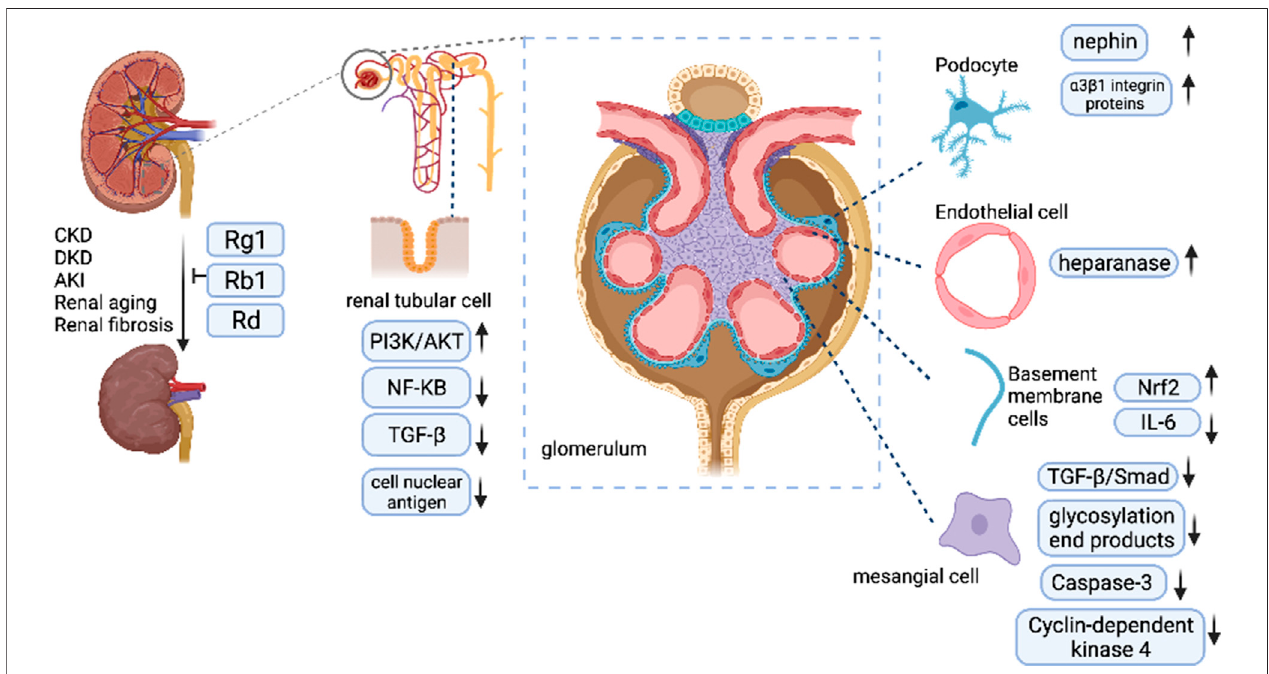
FIGURE 3 | Ginsenosides exert their kidney-protected